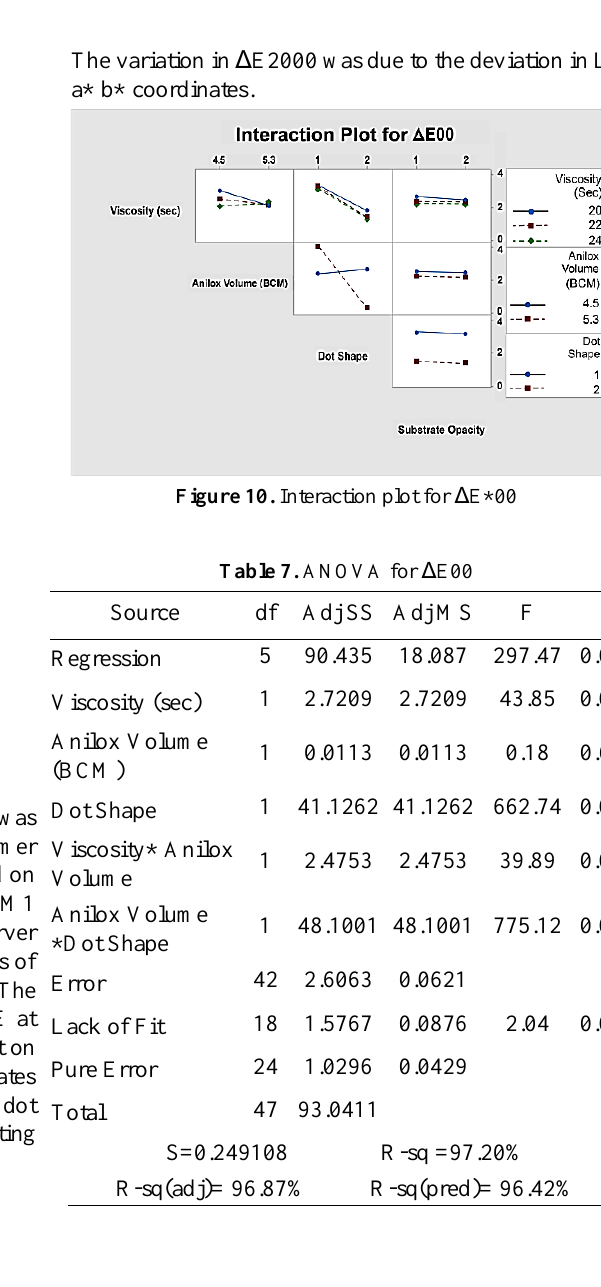
Figure 9. Main effect plot for Δ E*00.